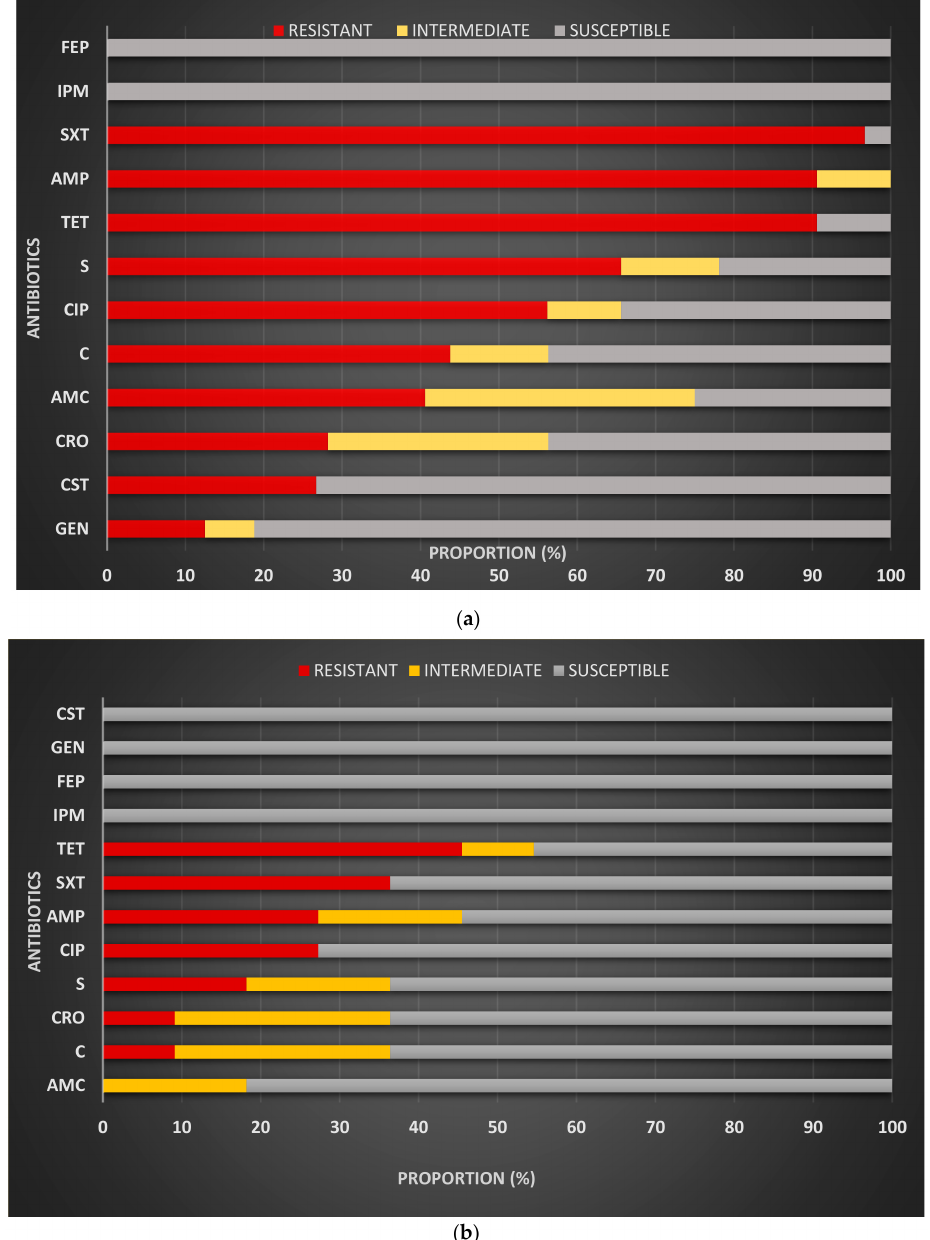
Figure 2. ( a ) Susceptibility and resistance patterns of E. coli spp isolated from chicken litter; ( b ) Susceptibility and resistance patterns of Salmonella spp. isolated from chicken litter. Legend: AMC (amoxicillin + clavulanic acid), AMP (ampicillin), C (Chloramphenicol), CIP (ciprofloxacin), CRO (cefrtiaxone), CST (colistin), FEP (cefepime), GEN (Gentamycin), IPM (Imipenem), S (strepromycin), SXT (trimethoprime + sulfamethoxazole), TET